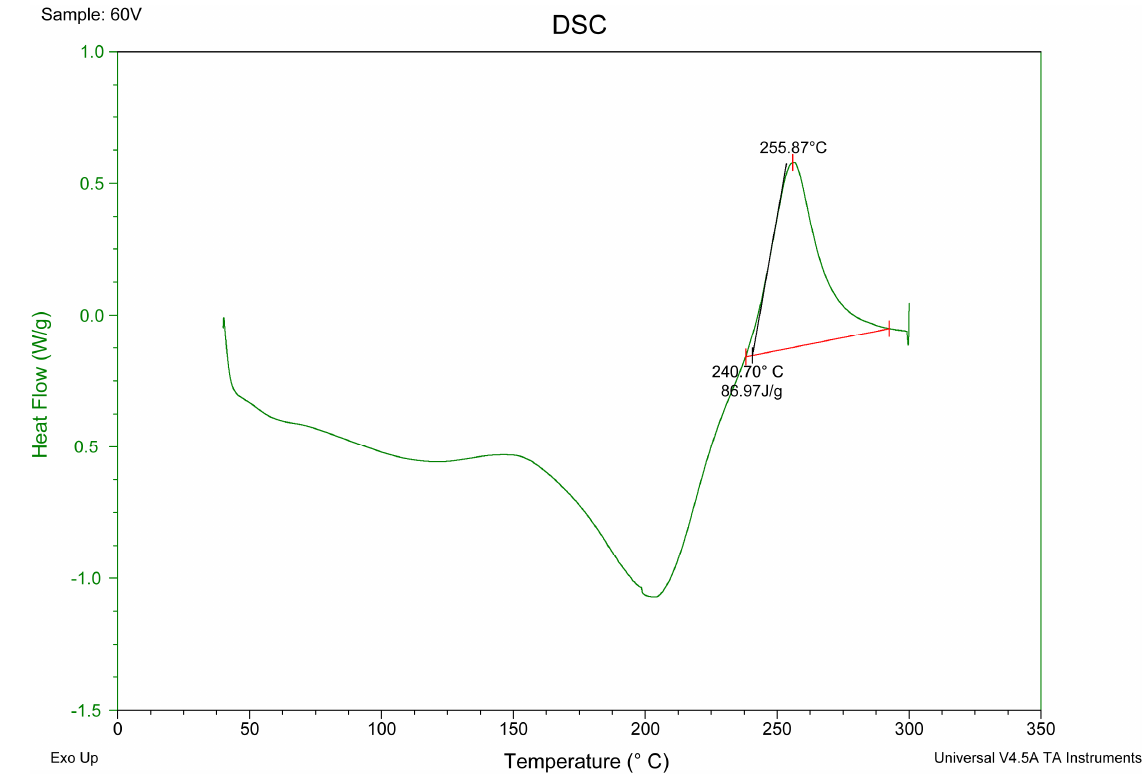
Figure 7. Calculation of the degradation temperature and enthalpy in DSC curves, based on sample 60U